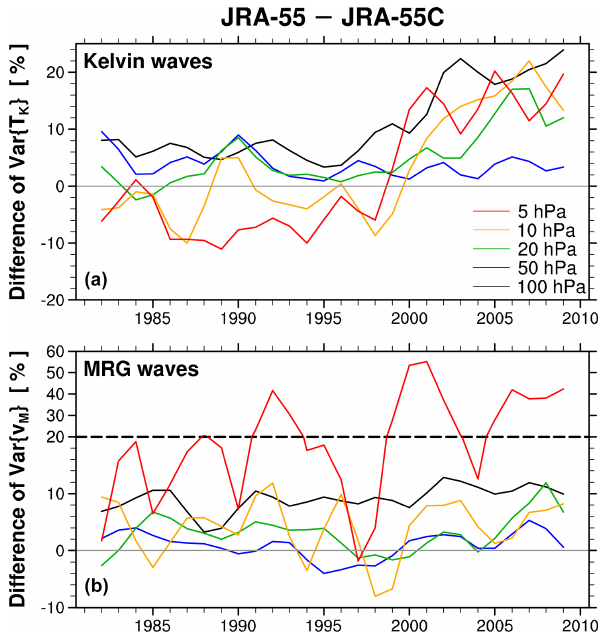
Figure 7. Differences in the annual-mean variances of (a) T Kelvin and (b) v MRG over 15 ◦ N–15 ◦ S between JRA-55 and JRA-55C, relative to the 30-year mean variances in JRA-55C, at various alti- tudes. The 1-2-1 smoothing is applied to the differences to filter out the interannual fluctuations by the QBO. The results are obtained from the model-level